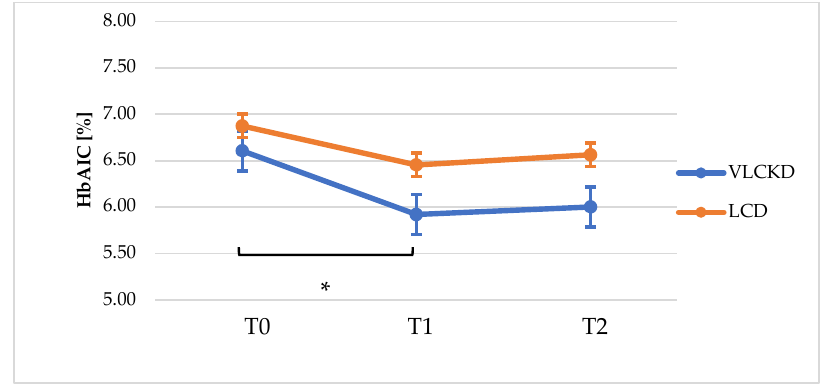
Figure 3. Kinetics of HbA1c values throughout the study (T0, T1 and T2). * p < 0.005.